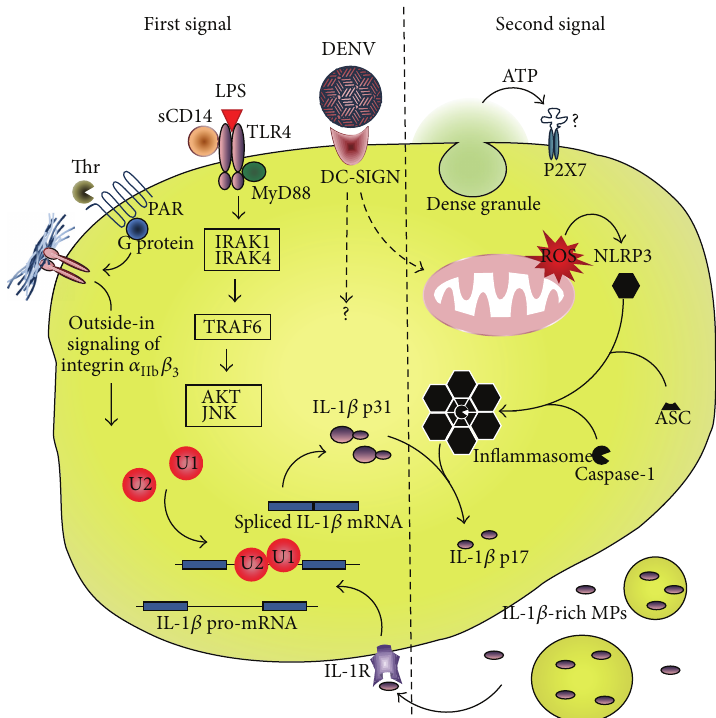
Figure 1: Inflammasome signaling in platelets. Schematic representation of the pathways leading to IL-1 𝛽 synthesis (first signaling, left) and inflammasome assembly (second signaling, right) in platelets in response to procoagulant or pathogen-associated